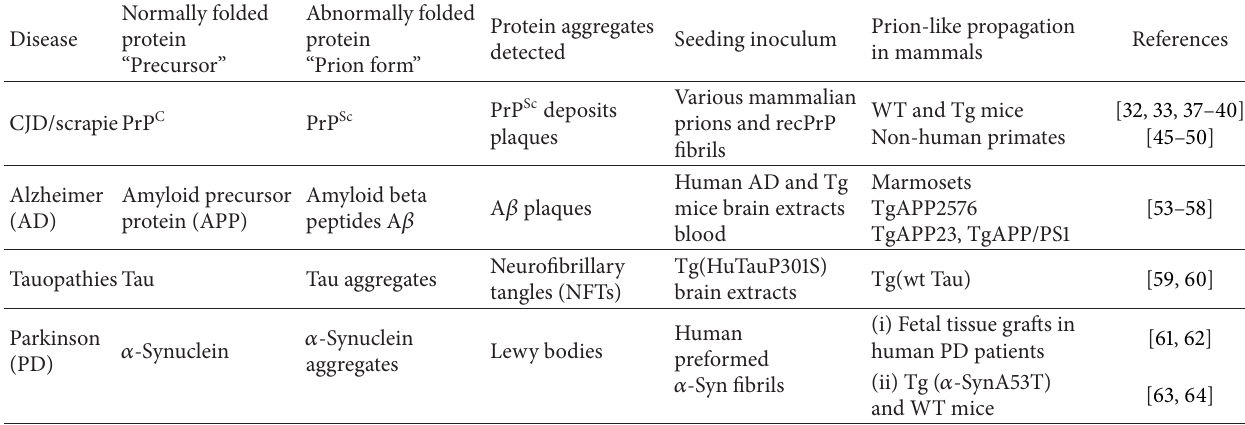
Table 1: Prion model of induction described for neurodegenerative